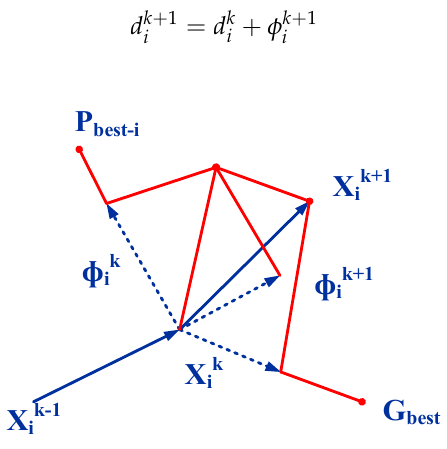
Figure 7. Movement of particles in the optimization process.